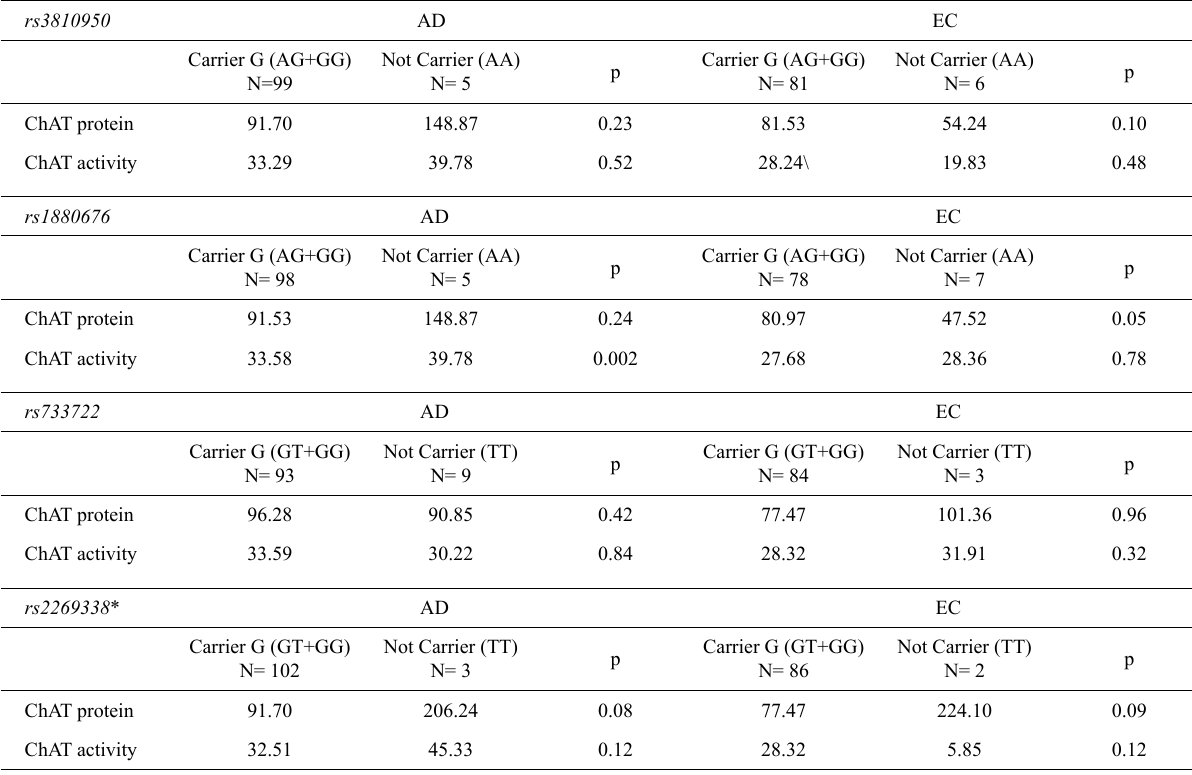
Table 3 – Comparisons between the median of ChAT protein concentration and activity in plasma, grouped by carrier and not allele carrier, for each specific SNP ( rs3810950 , rs2269338 , rs1880676 and rs733722 ) from (ADxAD; ECxEC).